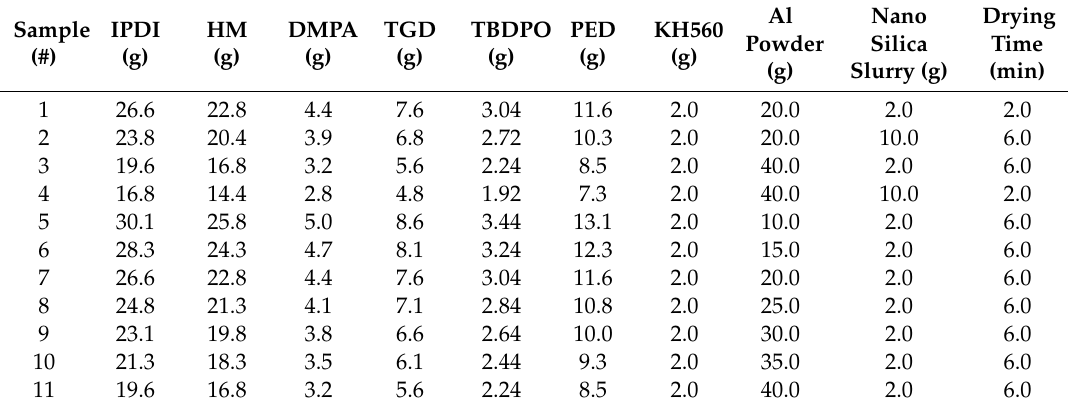
Table 1. Configuration information of the waterborne UV / Al low infrared emissivity coating.